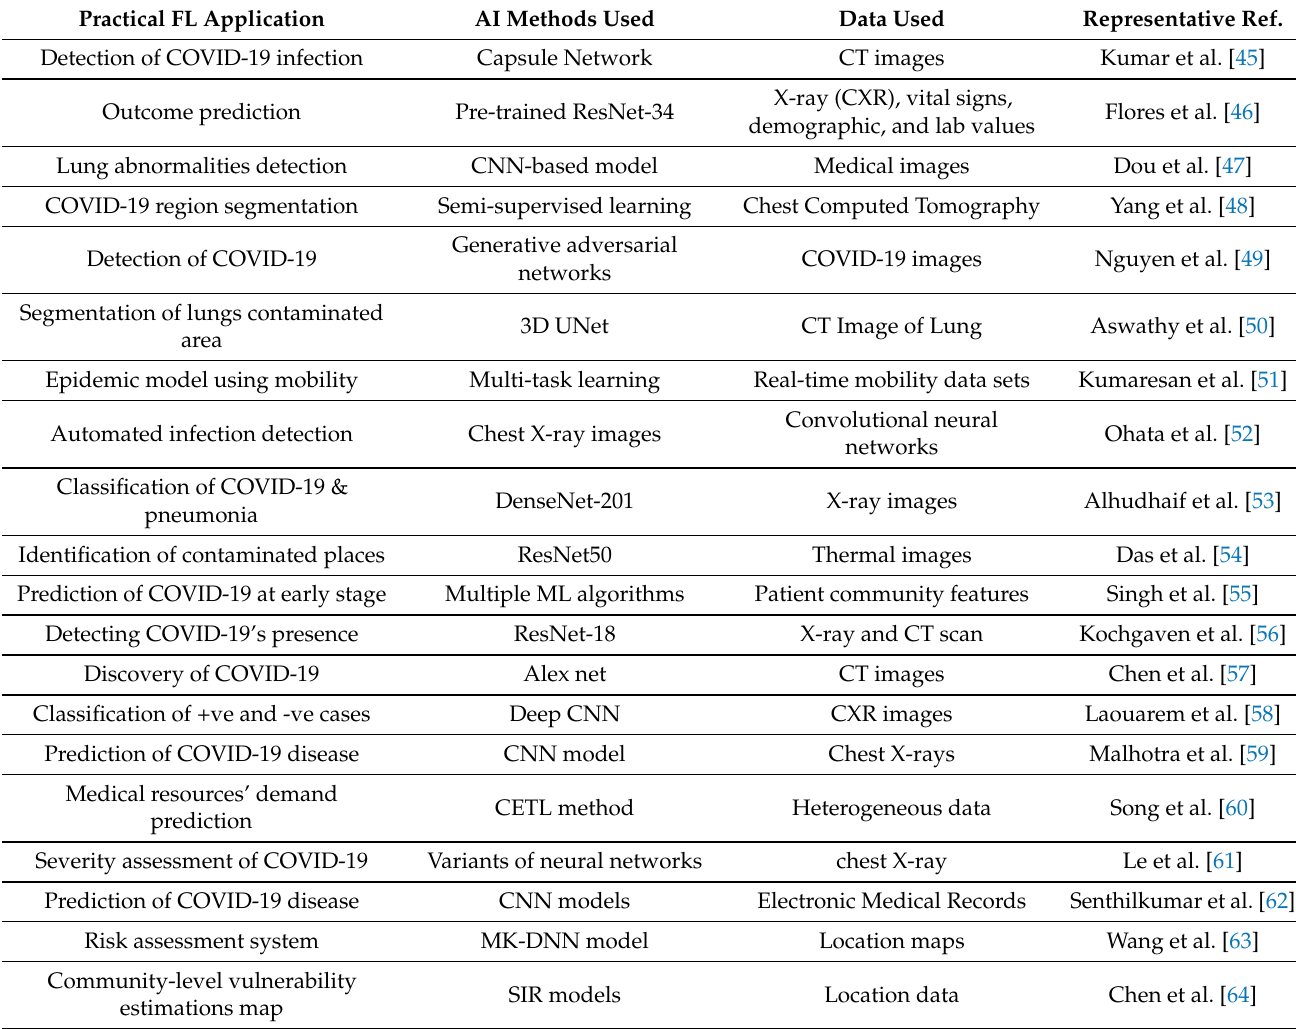
Table 2. Recently developed/proposed practical applications of FL in the context of